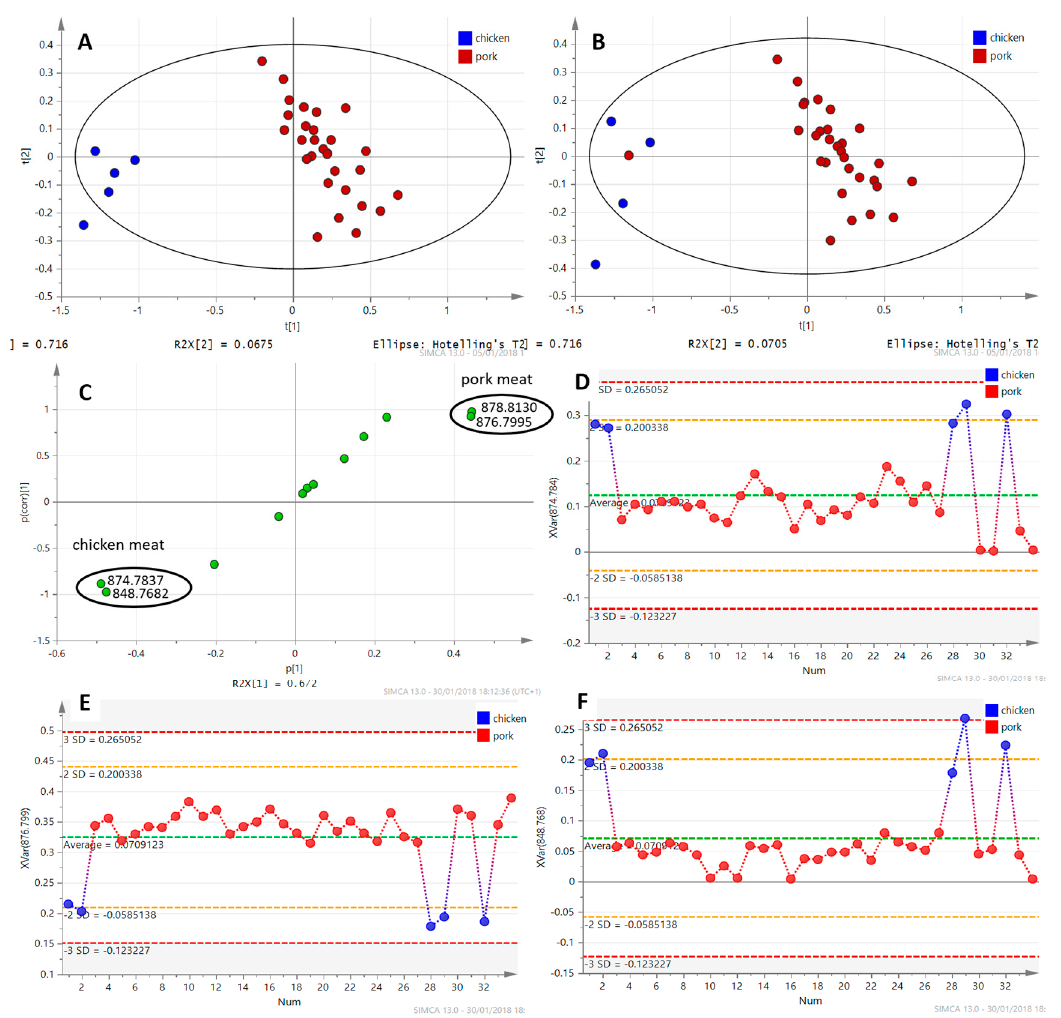
Figure 5. Examples of chemometric analysis of DART–HRMS data obtained from measurement of hexane extract of chicken and pork samples (meat and meat products). ( A ) PLS-DA plot; ( B ) PLS-DA plot illustrating the situation where the sample is adulterated; ( C ) S-plot and important chicken and pork markers; ( D ) variable line plot (trend plot) for ion m / z 874.7837—chicken meat marker; ( E ) variable line plot ion m / z 876.7995—pork meat marker; ( F ) variable line plot ion m / z 848.7682–chicken meat marker. Group of samples marked by number 1—four pork meat products which contained mechanically separated chicken meat.